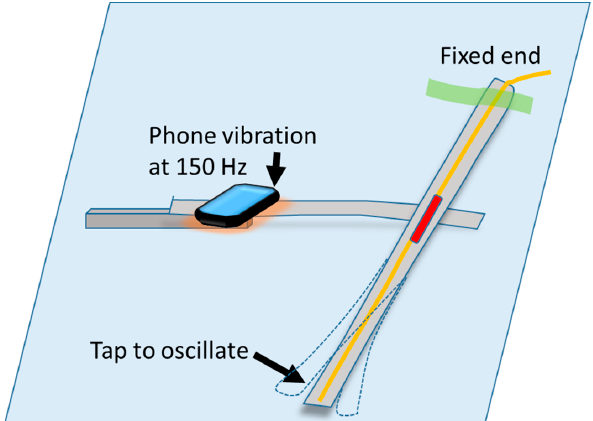
Figure 2. The schematic shows phone replacing the speaker, with top end of sensing beam lightly taped and bottom end allowed to oscillate. The sensing beam 2 was made to oscillate by tapping.